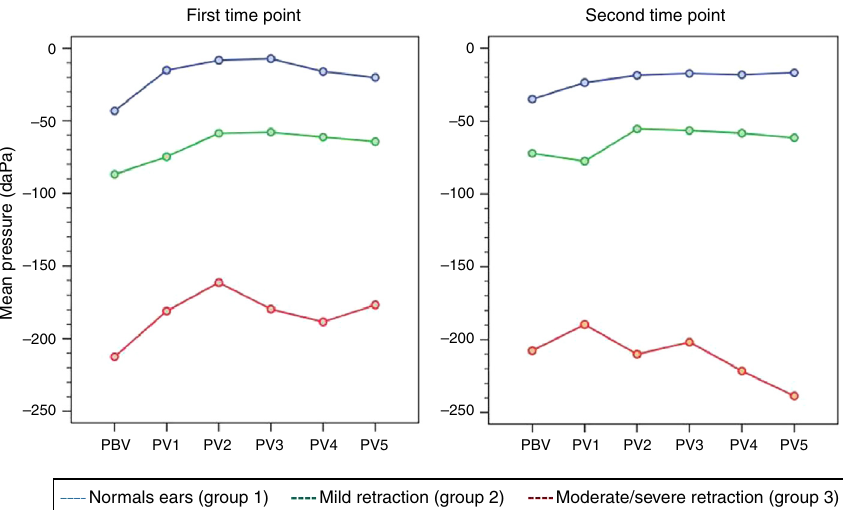
Variability of mean middle ear pressure measurements during Valsalva maneuver at the first and second time points of assessment.